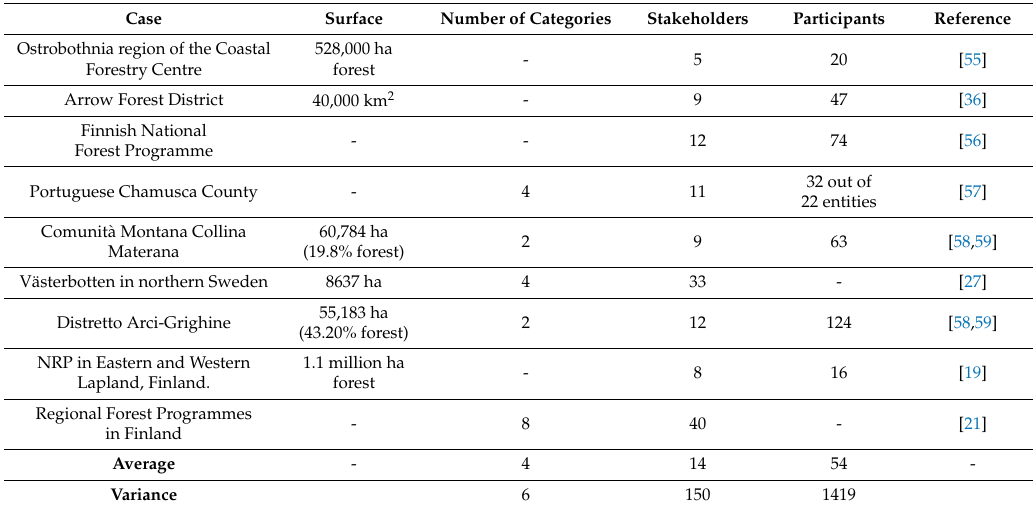
Table 1. Characteristics of participants in different public participation